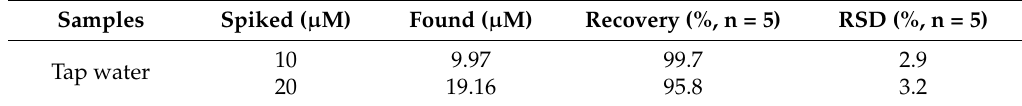
Table 3. Analytical results of tap water samples.